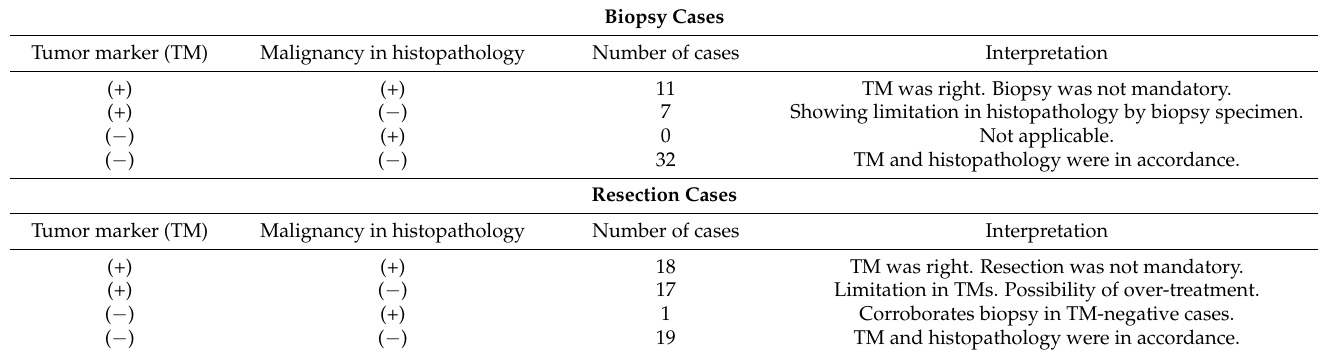
Table 3. Interpretation of the correlation of tumor markers and histopathology in biopsy and resection cases. For biopsy cases, 50 of 85 cases with both tumor markers available were included. For resection cases, 22 of 77 cases with only one tumor marker checked were not